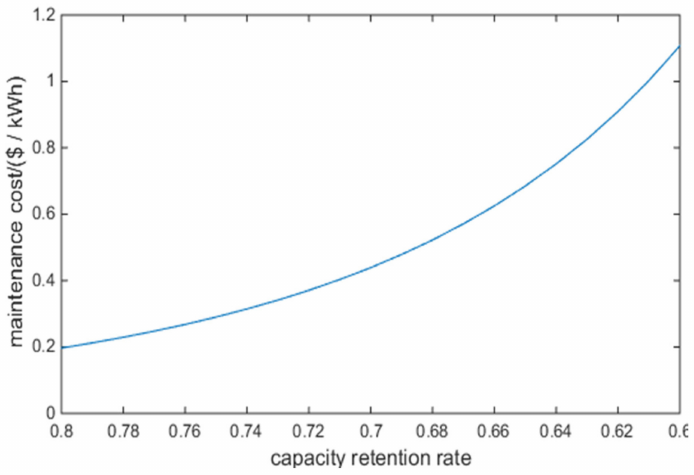
Figure 15. Maintenance cost